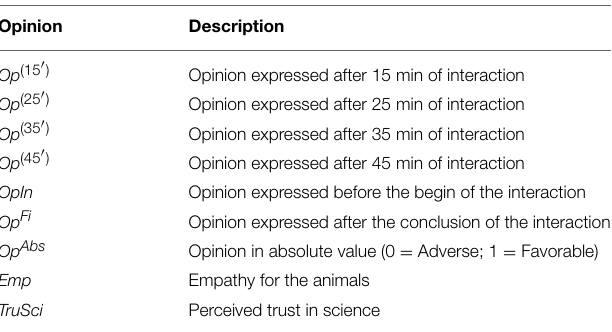
TABLE 2 | Opinion collection.